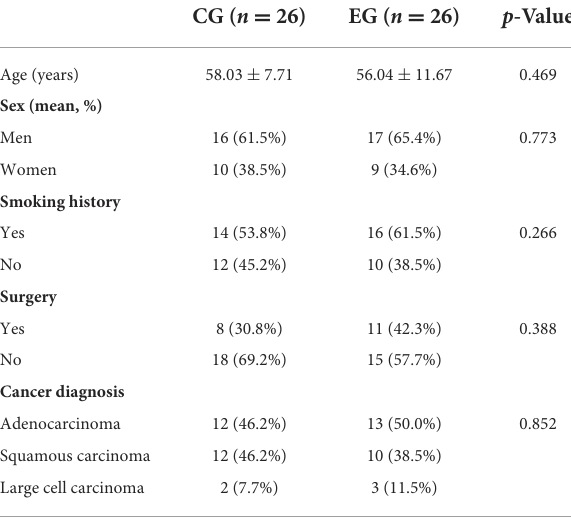
TABLE 3 The demographic and clinical characteristics of participants.